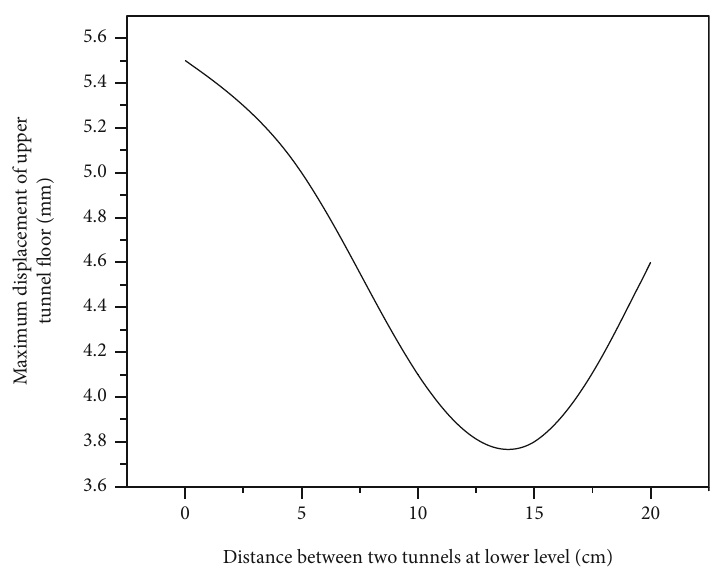
Figure 10: Maximum displacement of upper tunnel fl oor at di ff erent